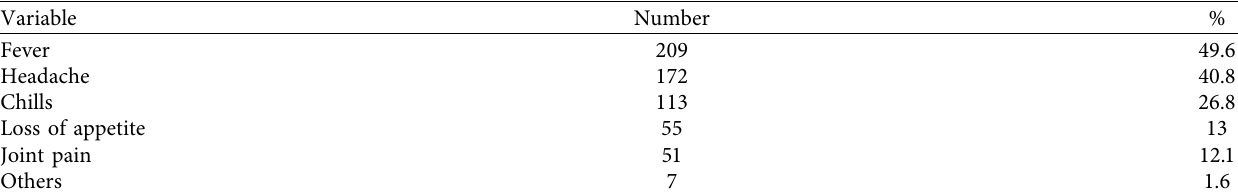
Table 3: Knowledge of respondents about symptoms of malaria in Halaba town, Southern Ethiopia, September